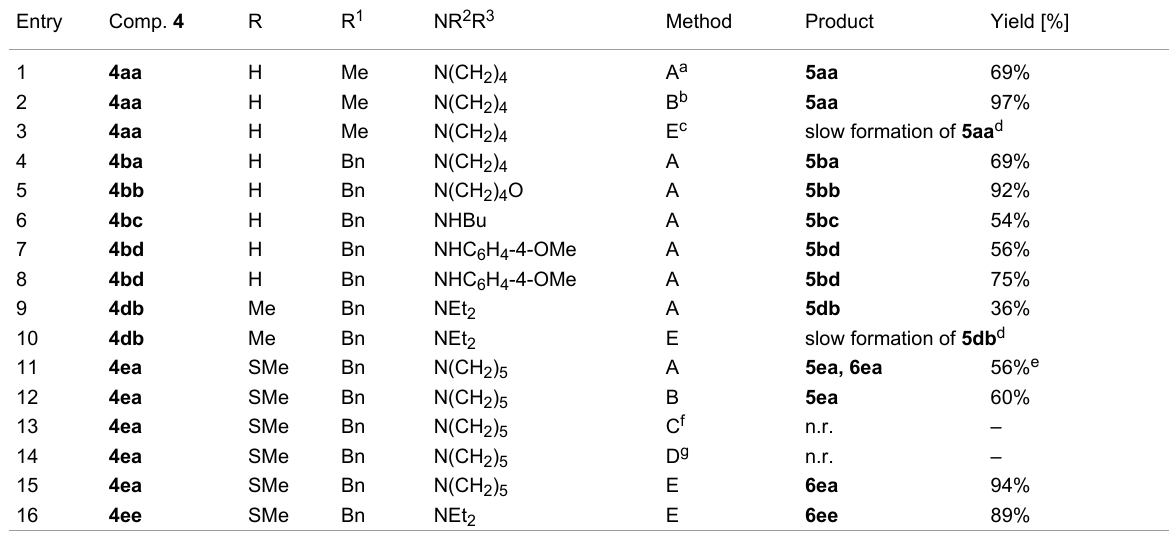
Table 1: Study on N -denitrosation reaction and intramolecular nitroso group transfer reactions in 6,- N -disubstituted- N